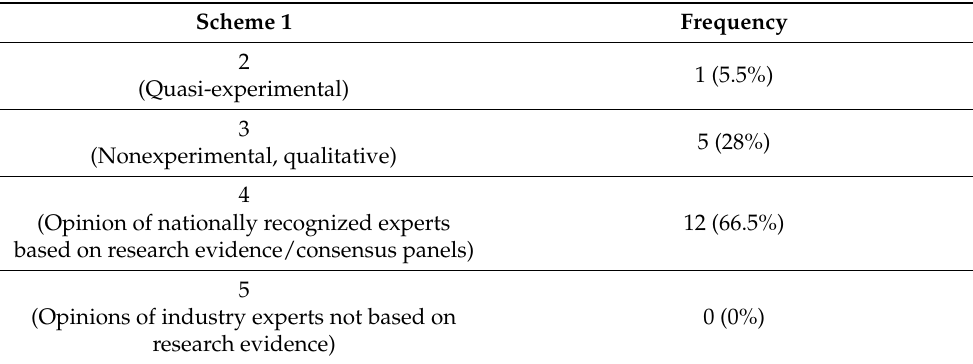
Table 3. Summary of quality assessments.